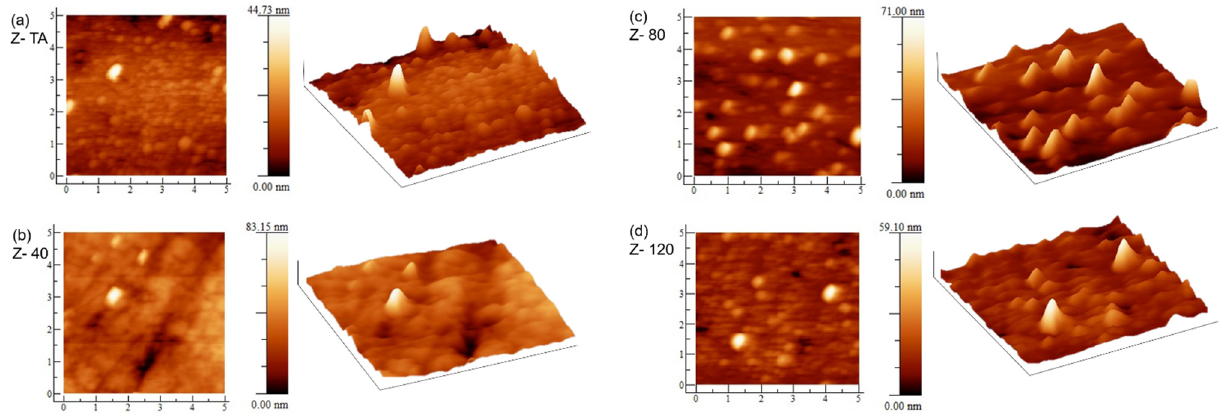
Figure 3. AFM images (2D and 3D) of ( a ) thermally annealed ZrO 2 film Z- TA and ( b – d ) UV-A treated ZrO 2 films Z40, Z80, and Z120. Change in surface morphology, with UV-A exposure time, is clear. The lengths of the sides in each image are 5 μ m.